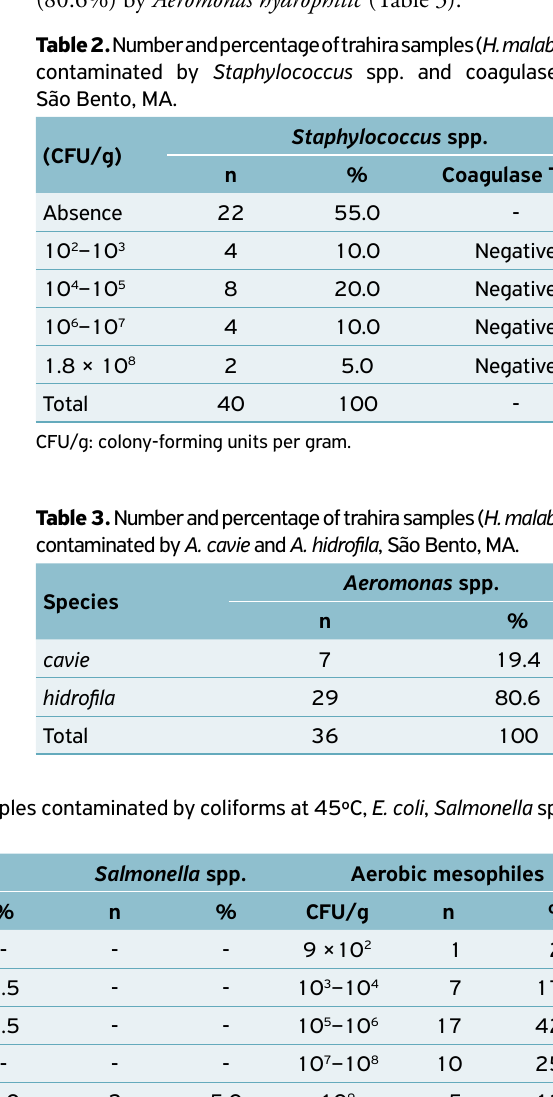
Table 2. Number and percentage of trahira samples ( H. malabaricus ) contaminated by Staphylococcus spp. and coagulase test, São Bento, MA.